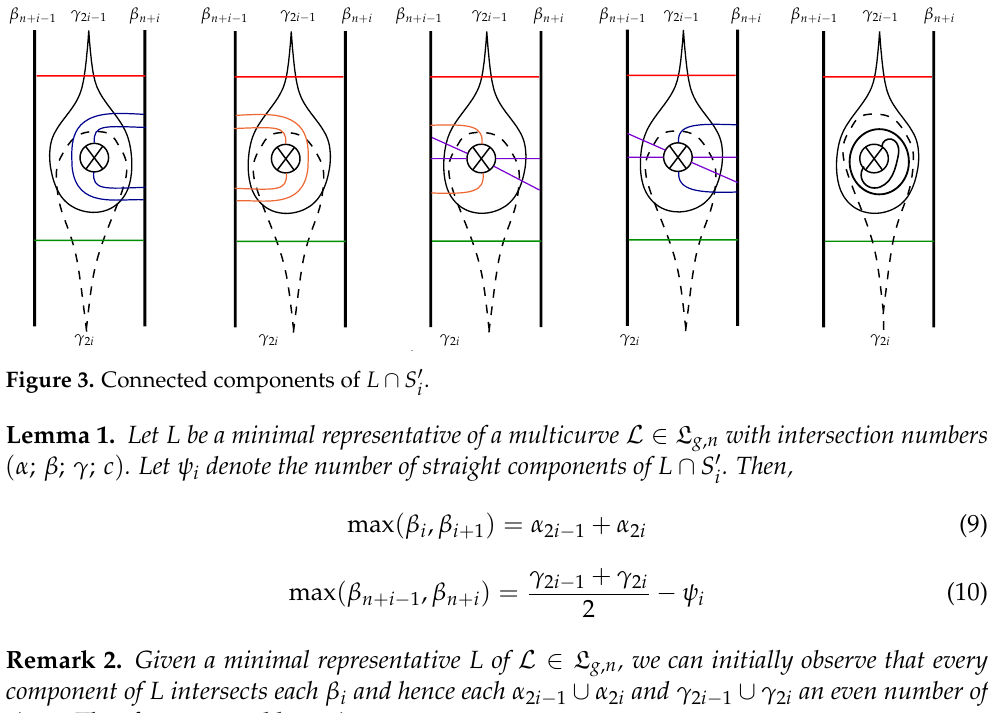
S i ∩ Figure 2. Connected components of L Figure 3. Connected components of L